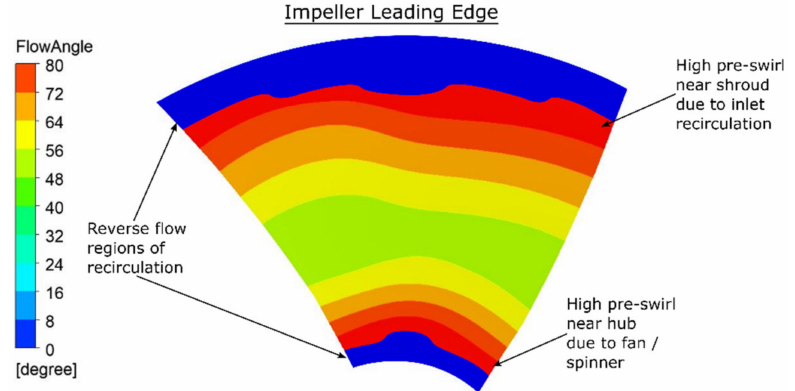
Figure 12. Absolute flow angle at 100 krpm surge point extracted from CFD.